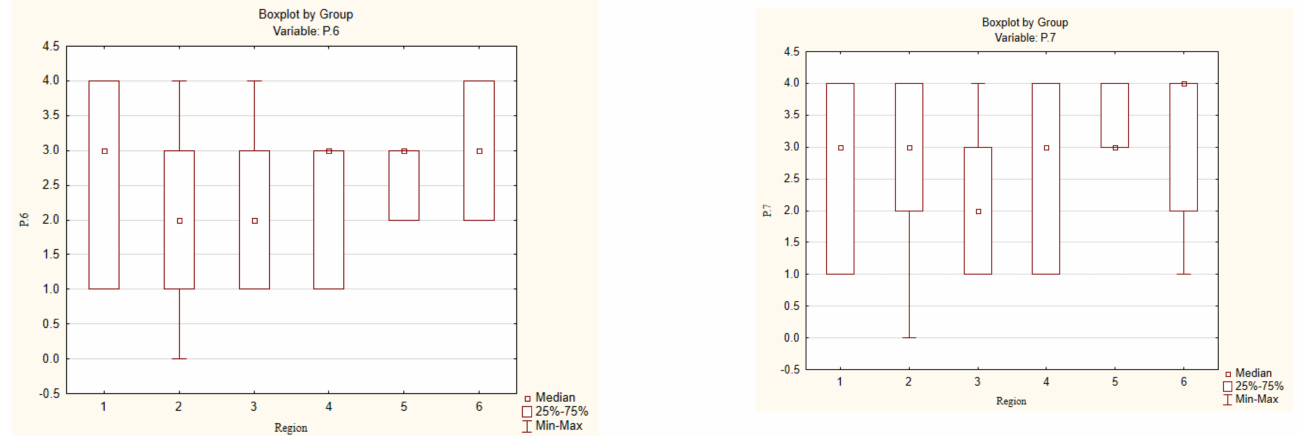
Figure 4. Box and whisker diagrams for practice P6 (Cleaning filter of the air conditioner or cleaner) and P7 (Adjusting the temperature of the air conditioner), the category “energy saving”.